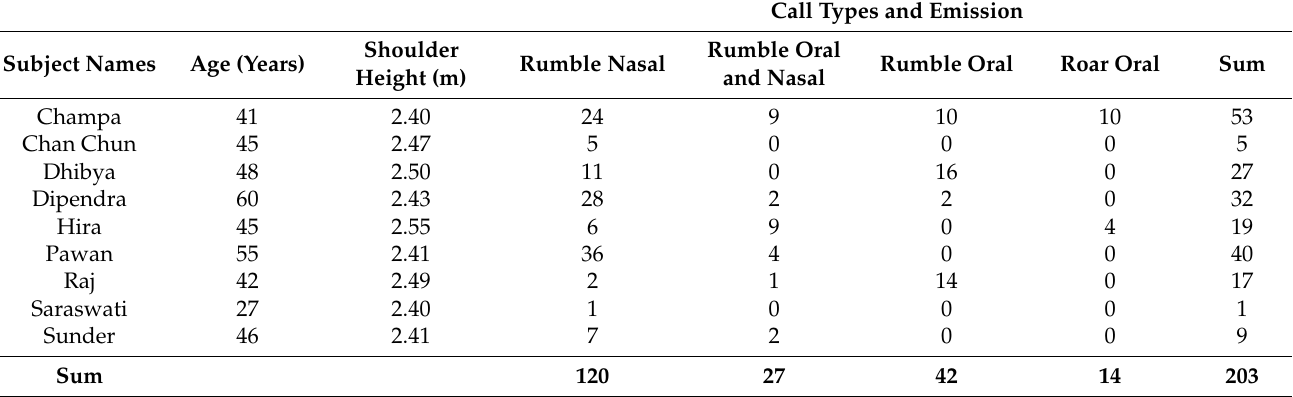
Table 1. Subjects and call sample sizes. Number of call types combined with emission per subject; the subjects estimated age according to their handlers at the time of recording; and the subjects shoulder height as a mean value of two